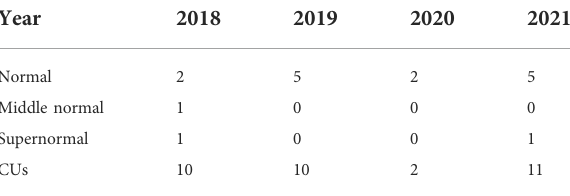
TABLE 2 Number of normal and supernormal valid